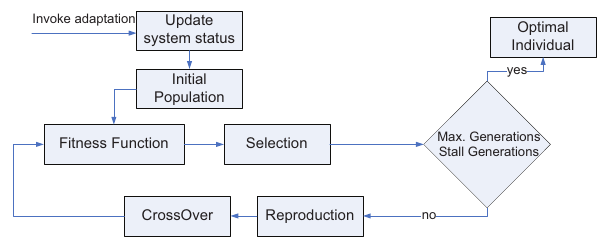
Table 8. Background load conditions and backhaul traffic